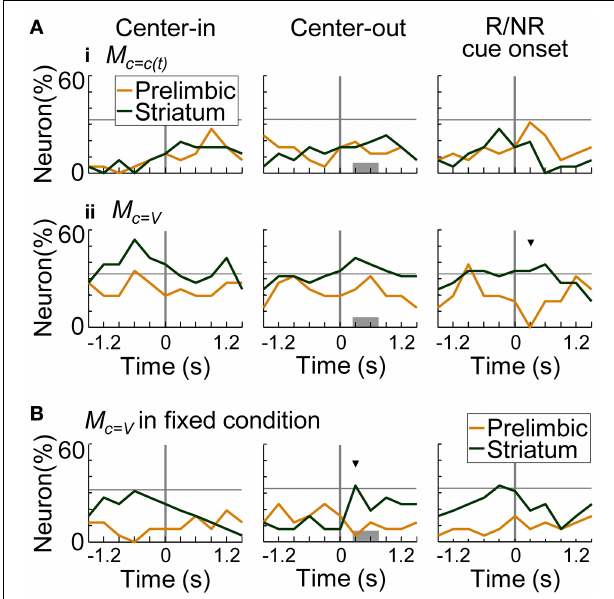
FIGURE 11 | Coding of values in variable-reward condition. (A) The proportion of neurons coding the values of the presented-trial condition (i) and of the variable-reward condition (ii) . In regression analysis with all trials, the proportion of neurons which had significant regression coefficients was shown: p < 0 . 01 in a two-sided Student’s t -test. Values consisted of five variables (i.e., action values for left and right choices, state value, chosen value, and policy) in the learning interference model. Lines and symbols as in Figure 8A . Dorsomedial striatal neurons mainly encoded values of the variable-reward condition. (B) The proportion of neurons encoding values of the variable-reward condition in fixed-reward-condition trials. Neurons representing values of the variable-reward condition were investigated with regression analysis using fixed-reward-condition trials. Lines and symbols as in (A)